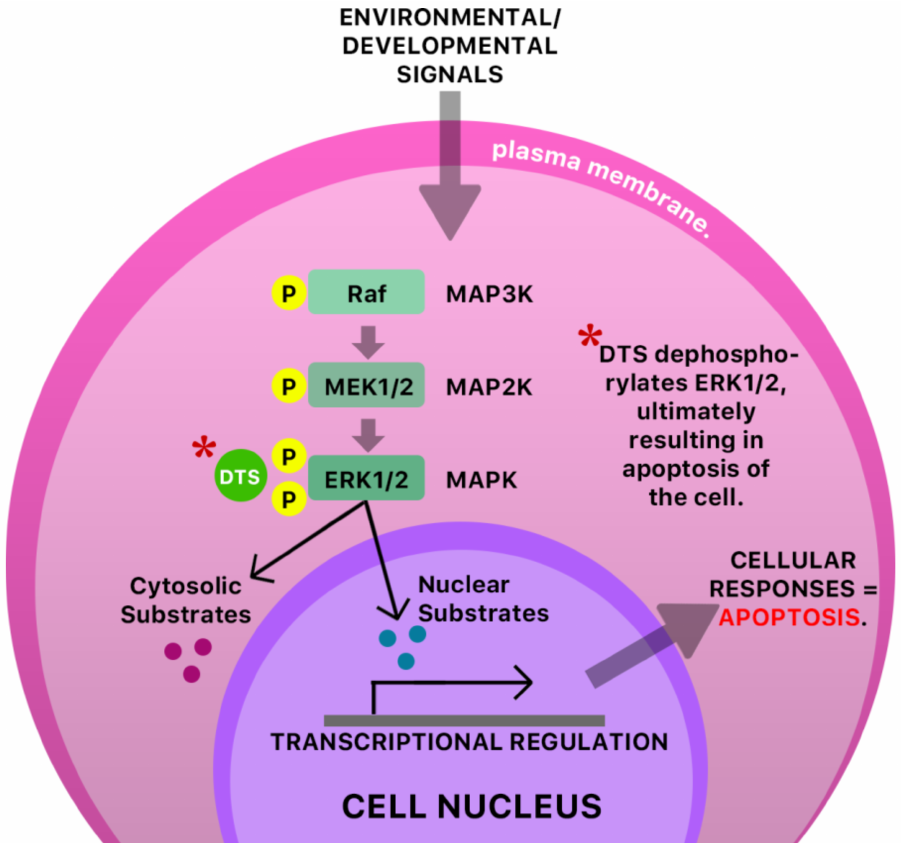
Figure 6. A possible antiviral mechanism of DTS in an infected cell. The mitogen-activated protein kinase/extracellular signal-regulated kinase (MAPK ERK1/ERK2 pathway) is a signaling pathway that is responsible for the transduction of protein components (chemical signals, transcription factors), MAP kinase kinase (MAP2K), and a final kinase, MAP kinase (MAPK), leading to the functioning and regulation of multiple cellular processes like cell proliferation, cell growth, and cell survival. A dysregulation of this pathway or any of its components typically has pathological consequences [43,44]. It has been proposed that some pathological conditions are characterized by increased phosphorylation of kinases [45], possibly resulting in over-proliferation of cells. Dibenzyl trisulfide (DTS) is shown to inhibit the MAPK ERK1/ERK2 pathway in cancer- and (possibly) virally infected cells via dephosphorylation of ERK1/2, ultimately resulting in apoptosis of the cell [45]. MAP—mitogen-activated protein; K—kinase; Raf—rapidly accelerated fibrosarcoma; MEK— mitogen-activated protein